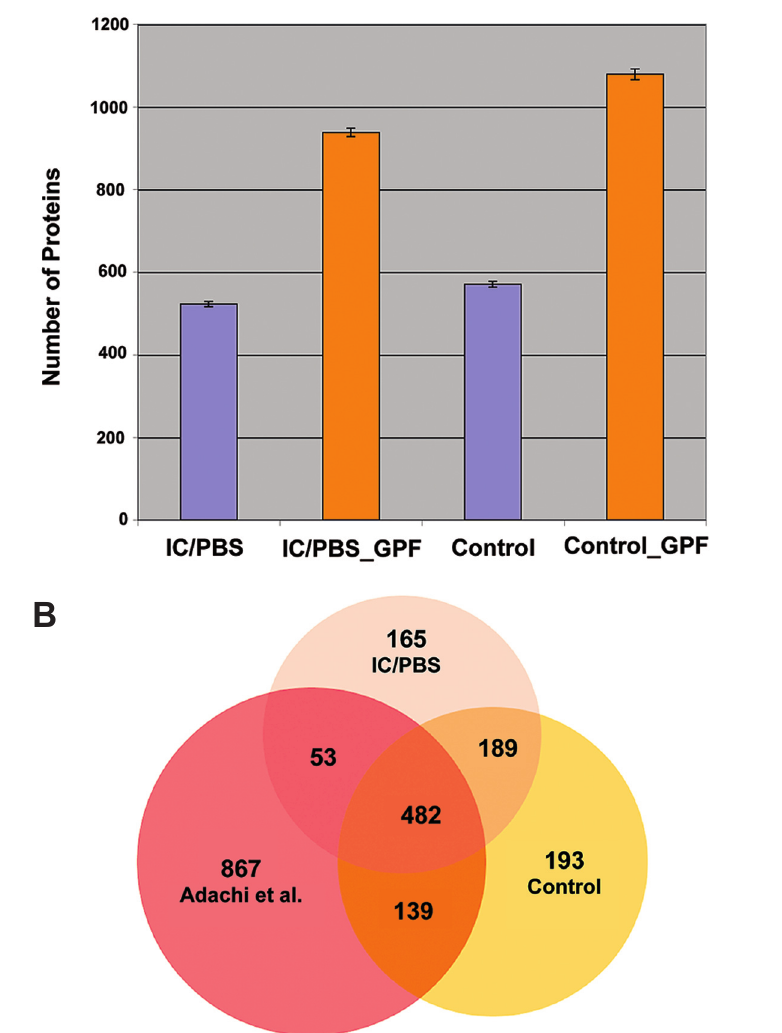
Figure 1 - IC/PBS and control urine protein identifications. (A) Average number ± standard deviation (on 4 technical replicates) of identified proteins with 2 or more peptides (multiple hits) using single m/z or 4 gas-phase m/z fractions for IC/PBS and control urine. (B) Our urinary proteome of IC/PBS and controls were compared to the previously reported normal urine proteome (Adachi et al. 2006). The Venn diagram shows overlapped proteins (621) between our asymptomatic control proteins and previously published healthy urine proteins. This comparative analysis also identified 165 proteins that may be unique to the IC/PBS proteome. However, proteins identified in one sample only may be due to under-sampling in other sample or result from data